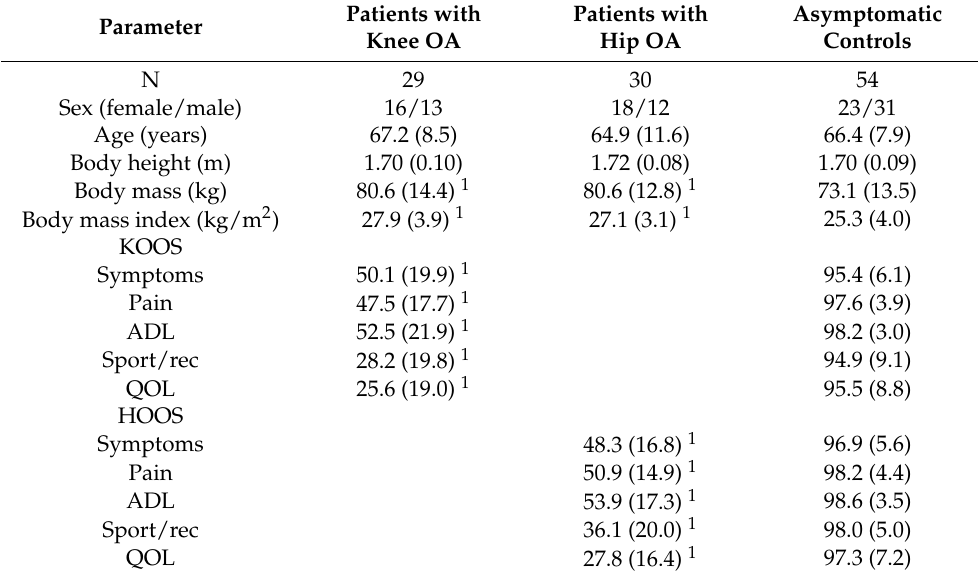
Table 1. Demographics of patients with knee OA, patients with hip OA and asymptomatic controls. Values for personal parameters are shown as mean (1 standard deviation).